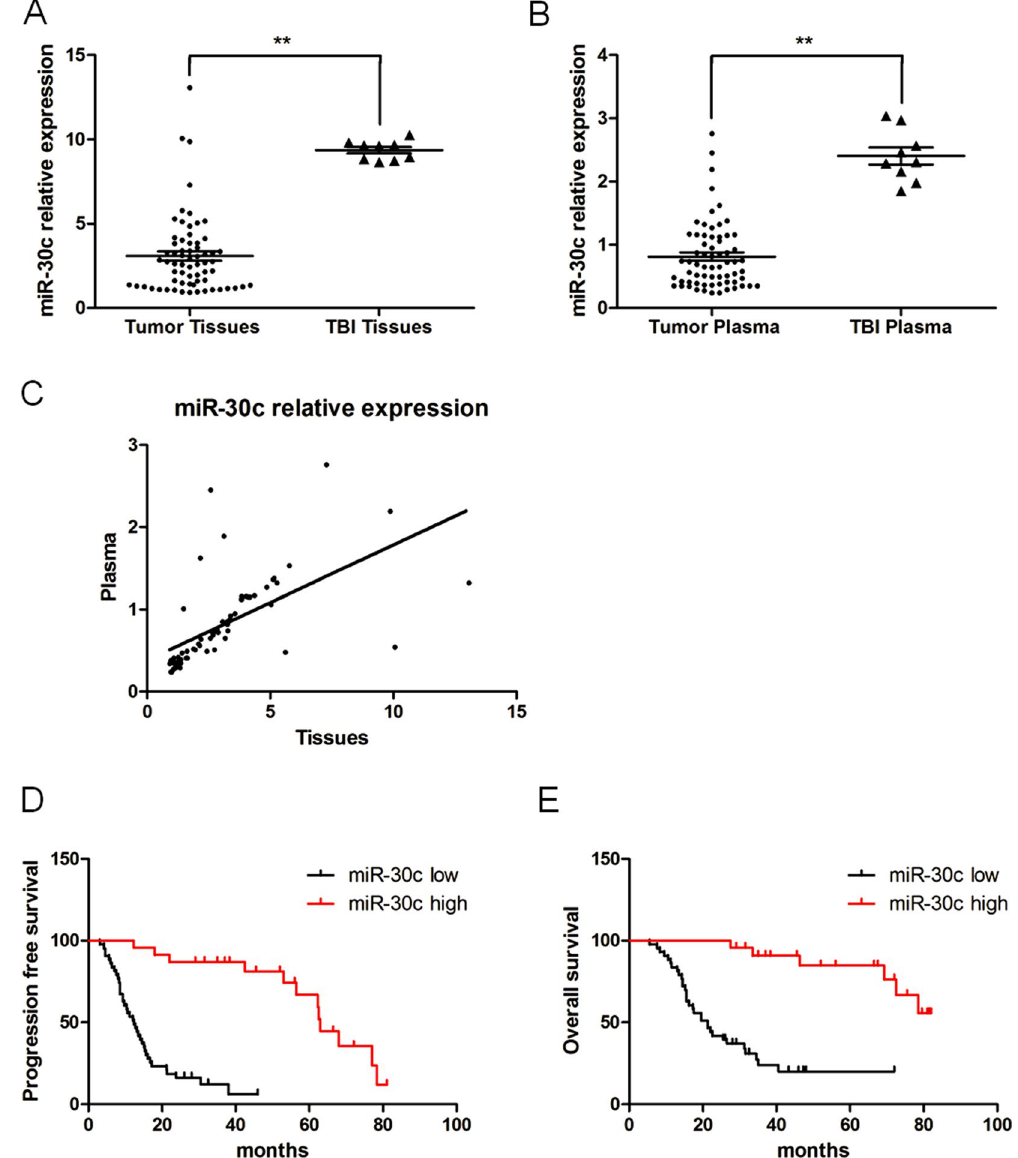
Figure 1. The expression levels of miR-30c in human glioma tissue, preoperative plasma, and paraffin specimens. ( A ) The expression levels of miR-30c in glioma tissues were significantly lower than the levels in normal brain injury tissue (** P < 0.01). ( B ) The expression levels of miR-30c in the plasma of patients with glioma prior to operation were significantly lower than the levels in healthy volunteers (** P < 0.01). ( C ) Correlation analysis of miR-30c in glioma tissue and plasma. ( D , E ) The PFS and OS of patients with high miR- 30c expression were significantly longer than those of patients with low miR-30c expression ( P <